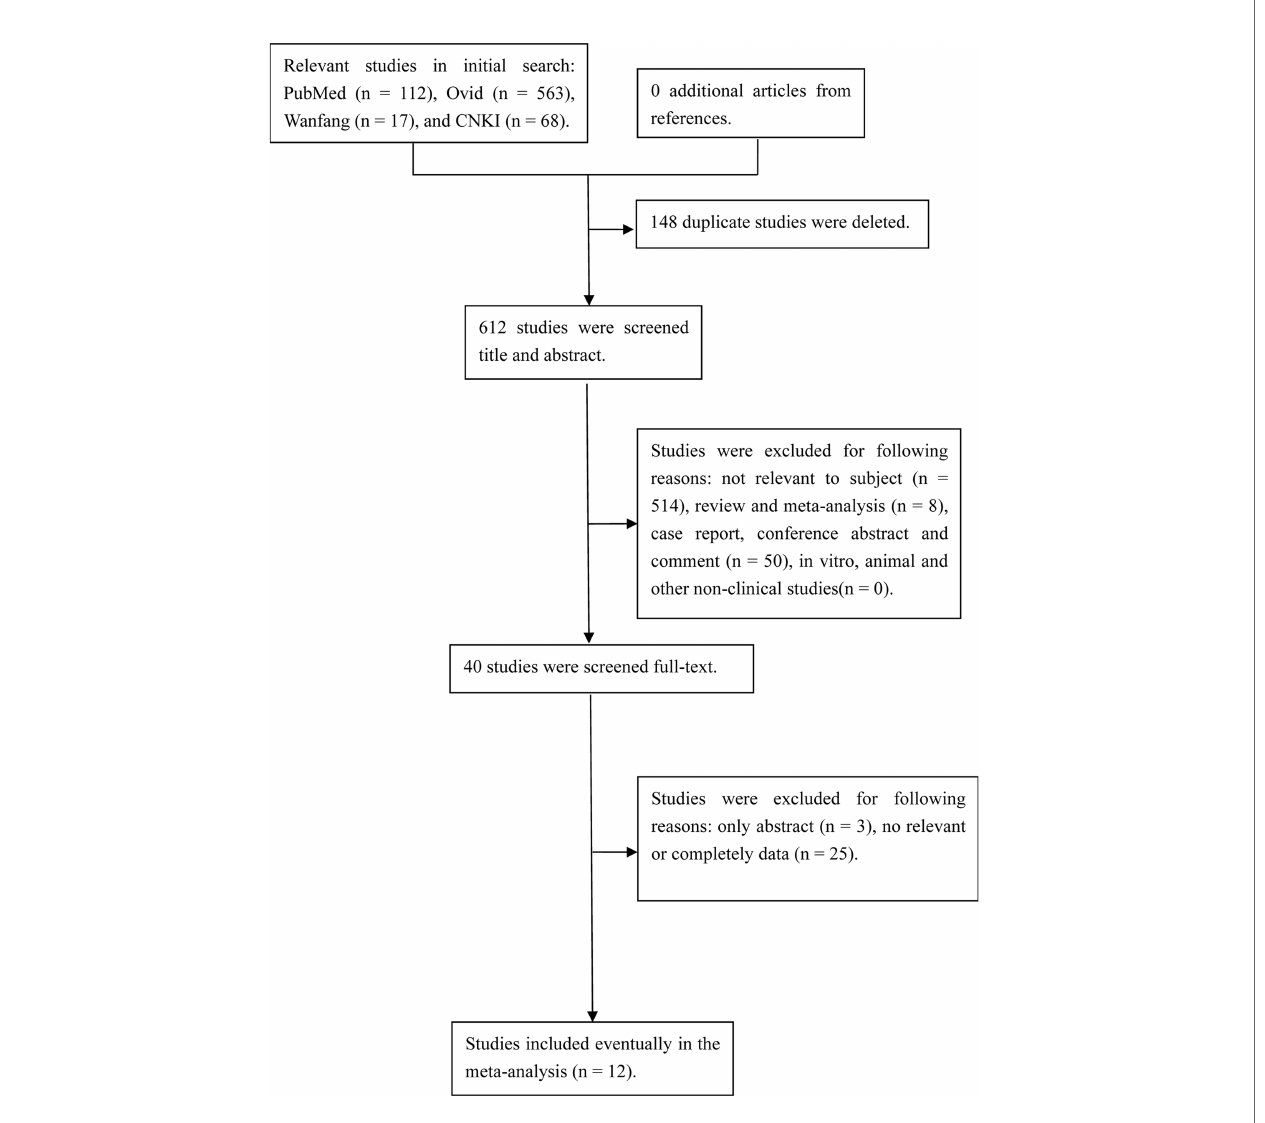
FIGURE 1 | Flow diagram of the literature